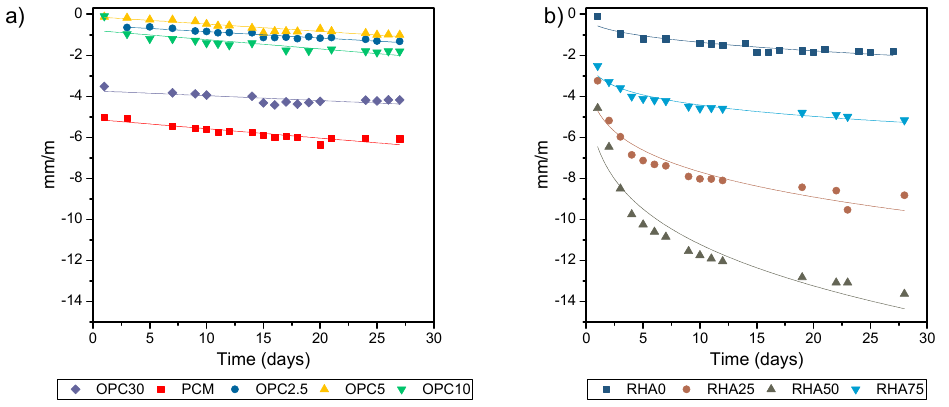
Figure 7. Drying shrinkage: ( a ) Binary mortars; ( b ) Ternary mortars.